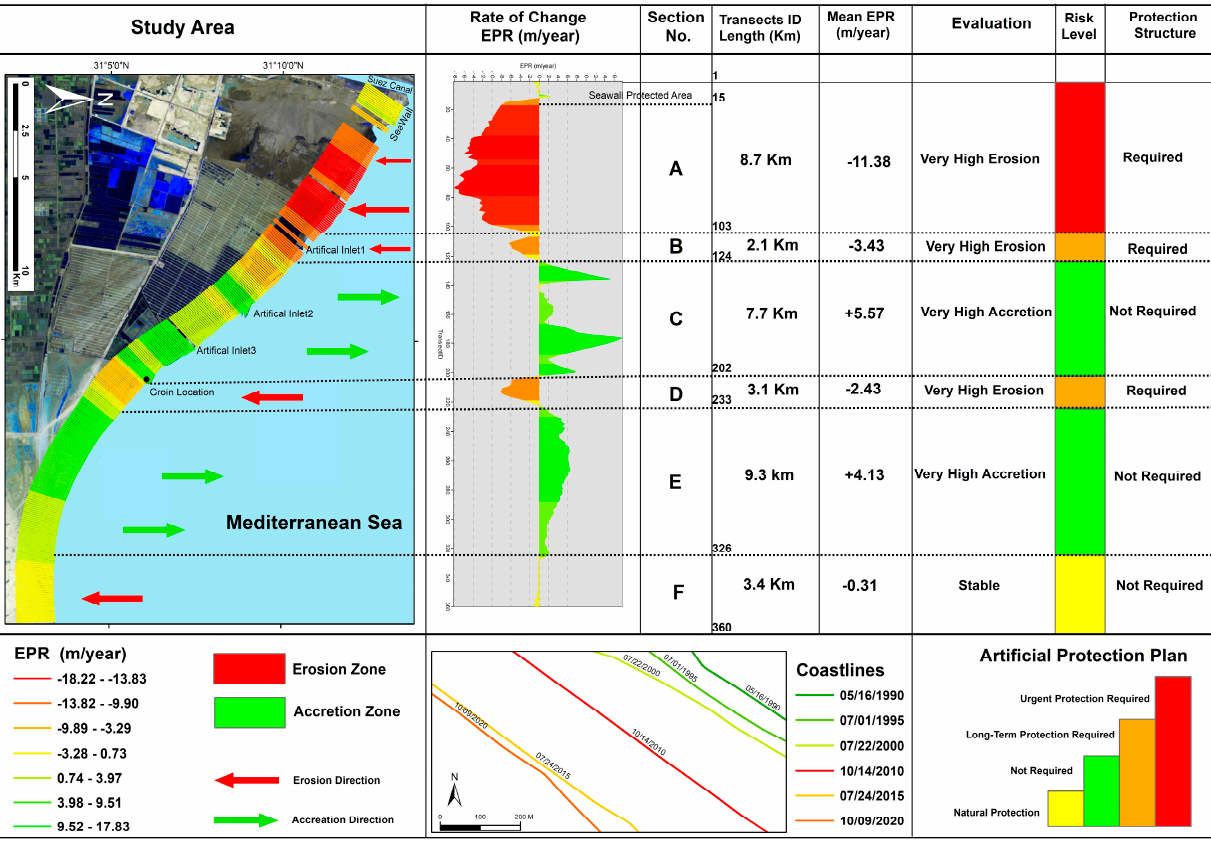
Figure 13. Coastal Structure along the Bardaweil Artificial Inlets ( a ) Inlet-1 ( b ) Inlet-2. The green arrow refers to the accretion zone behind the western Jetty, while the red arrow refers to active erosion zone downward. The CEDM identified seven sub-regions along the BLBC zone based on EPR coastline erosion/accretion rates between 1990 and 2020. Two sub-regions, C and F, located east- ward of the entrance of artificial inlets at 11.7 km., had erosional rates of 3.9 and 4.0 (m/yr.), respectively, which require protection, as shown in Figure 14.